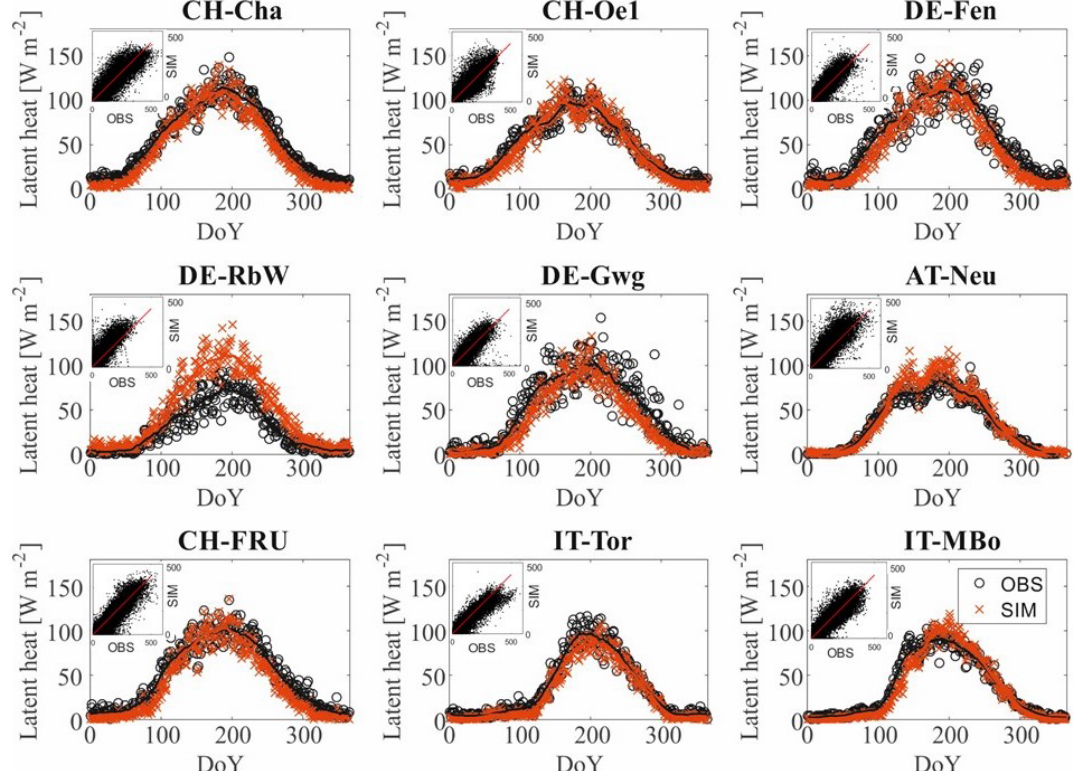
Figure 2. Observed versus simulated seasonal daily latent heat fluxes. We compare the observed (black circles) and simulated (red crosses) seasonal pattern of latent heat computing the average value for every day of the year (DoY) considering all the years for which observations are available. We also apply a moving average with a centered window of 30d (continuous lines). In the upper left corner of each subplot, a scatter plot comparison of the hourly values of observed and simulated latent heat is shown. In red is plotted the 1 : 1